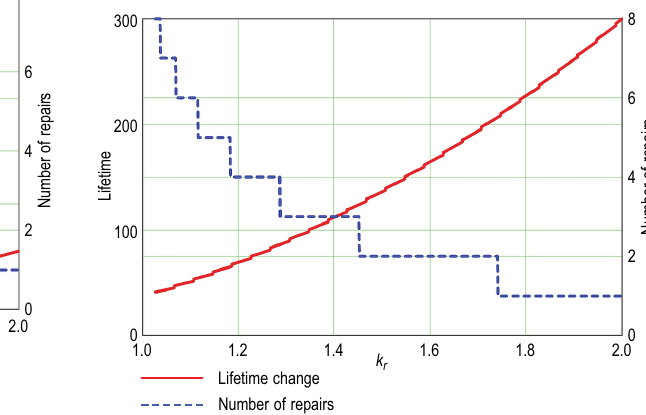
Fig. 4. Dependence of repairing cost and repair amount from the reserve coefficient